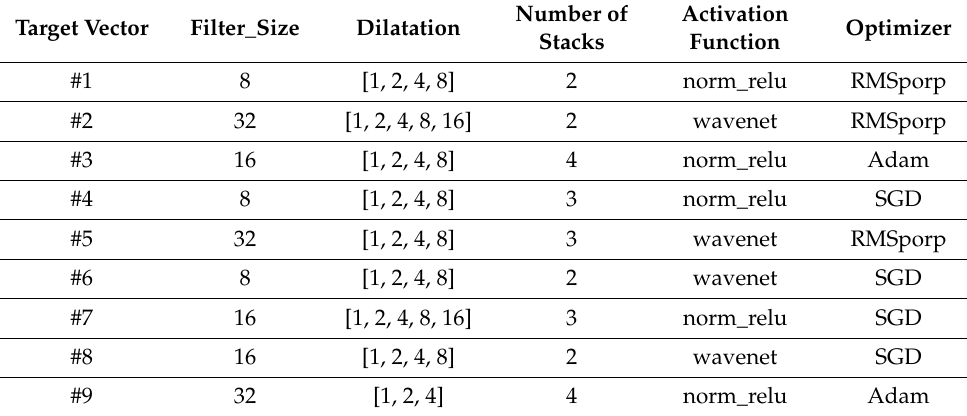
Table 6. The parameter settings for the nine trial vectors.